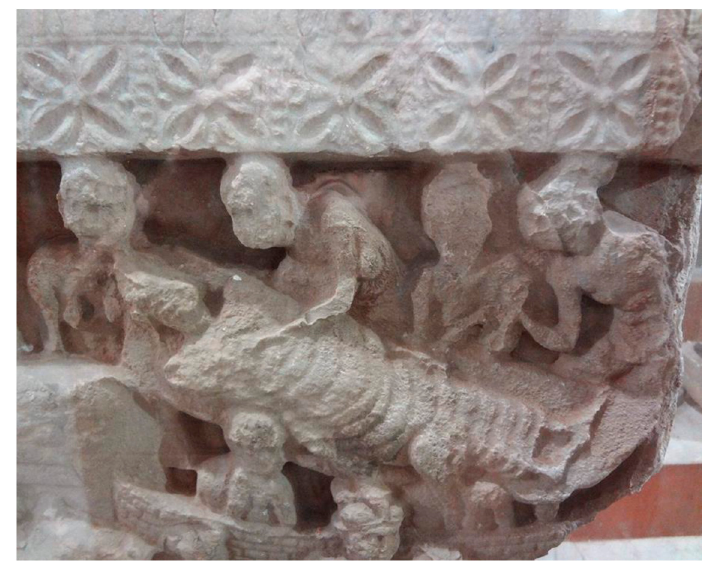
Figure 7. Part of relief no. 124 in Chennai Government Museum © photograph Wojtek Oczkowski. Religions 2020 , 11 , 103